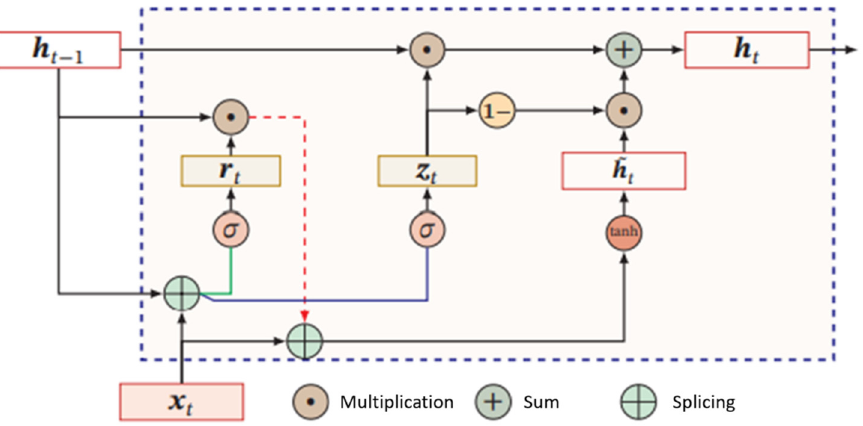
Figure 9. Cycle unit structure of GRU [72].